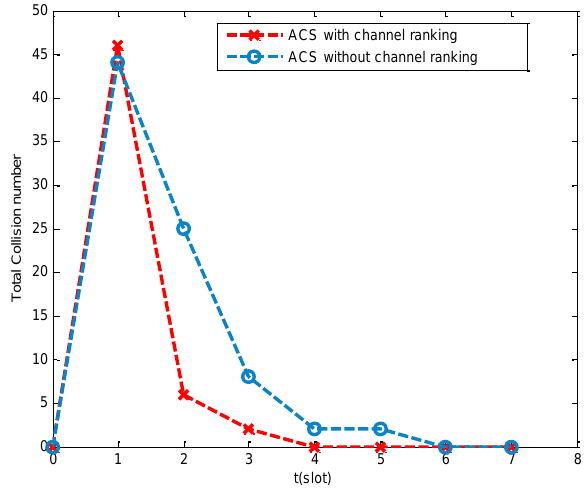
Figure 8. Convergence time under different available channel set (ACS).